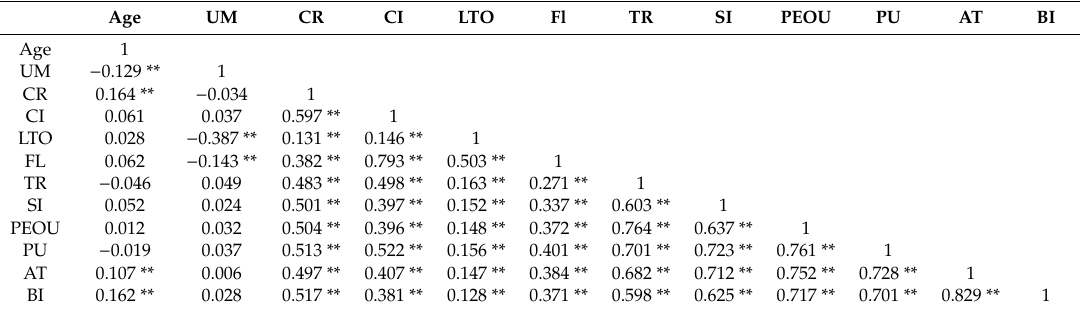
Table 4. Correlation coe ffi cients between measured variables.